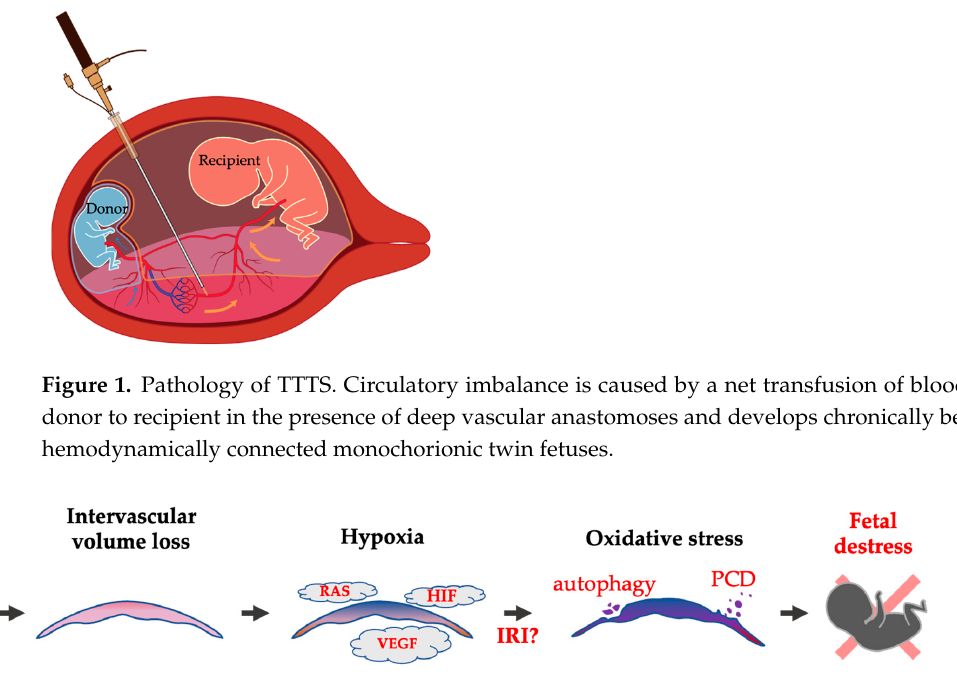
Figure 2. Events assumed to be occurring in the donor placenta. Abbreviations: HIF: hypoxia in- ducible factor; IRI, ischemia-reperfusion injury; PCD, programmed cell death; RAS, renin–angiotensin system; VEGF, vascular endothelial growth factor